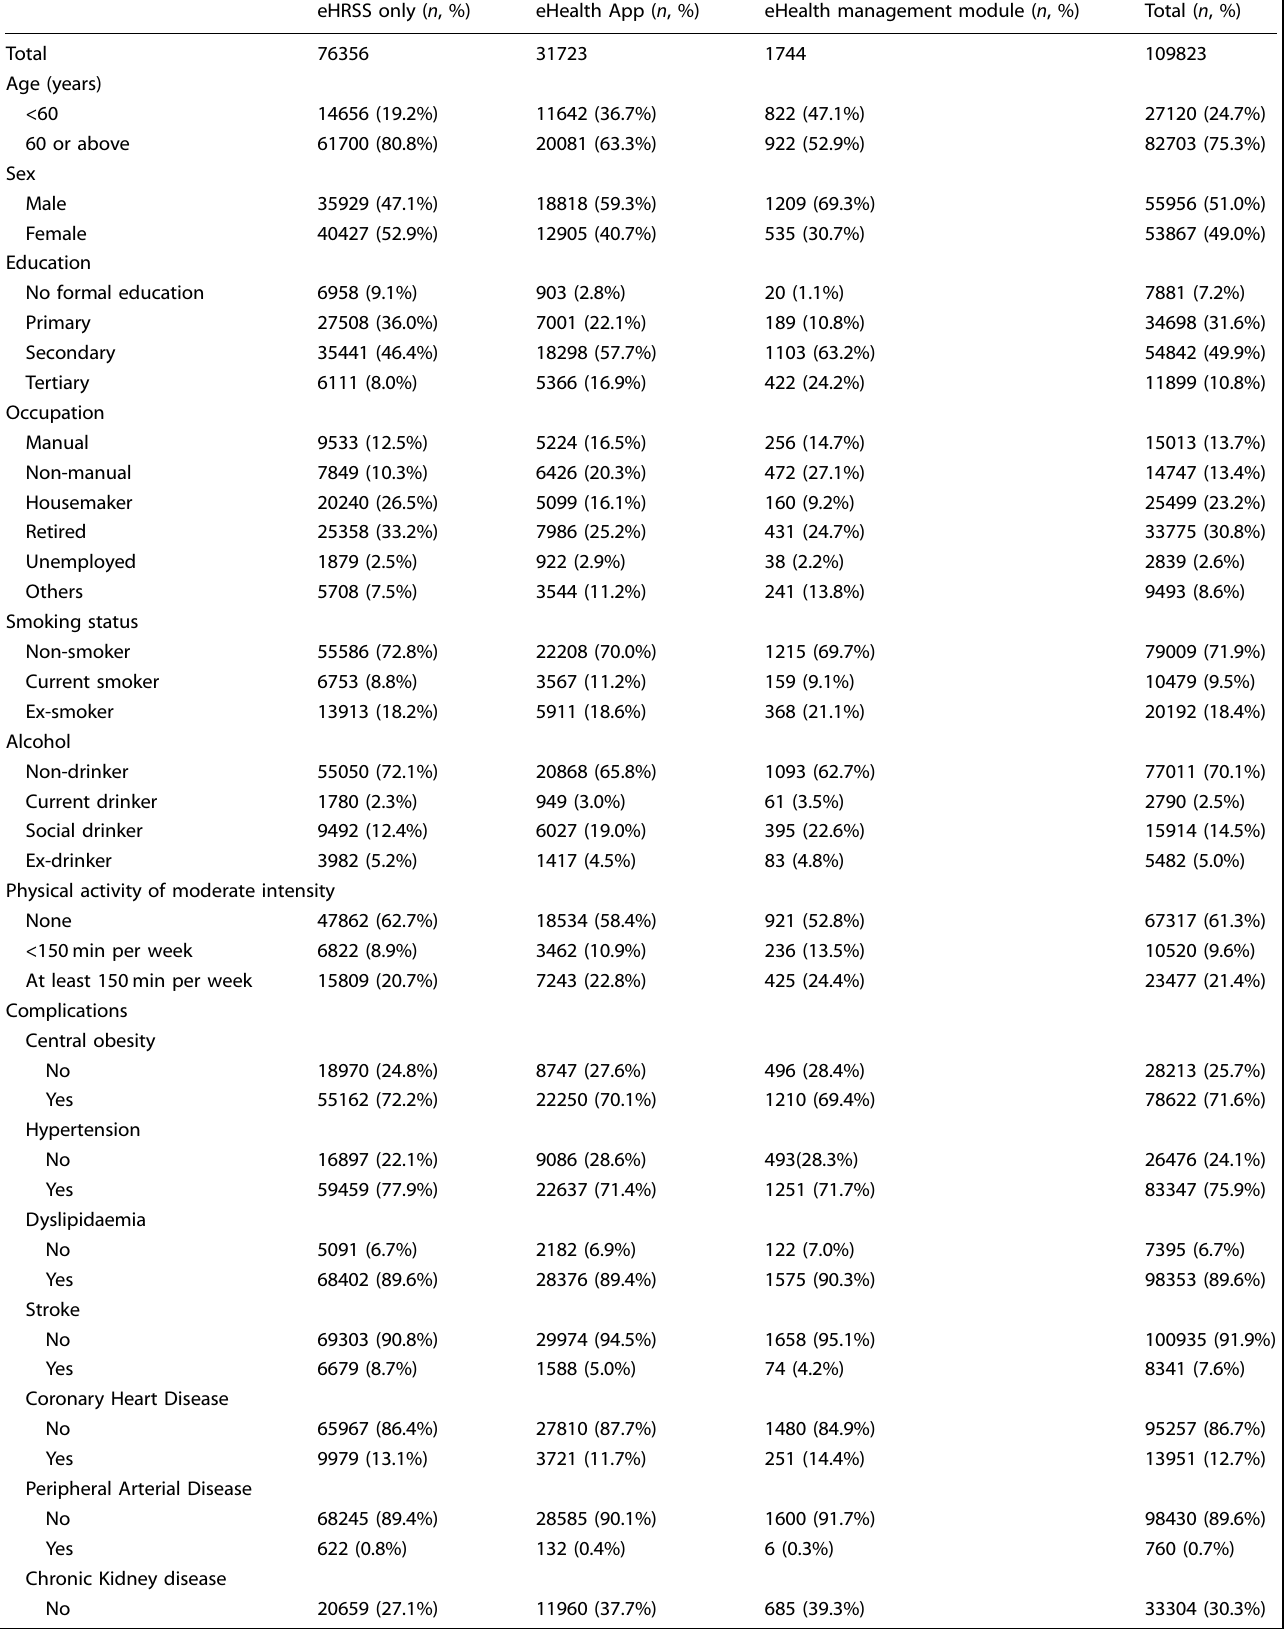
Table 1. Characteristics of the